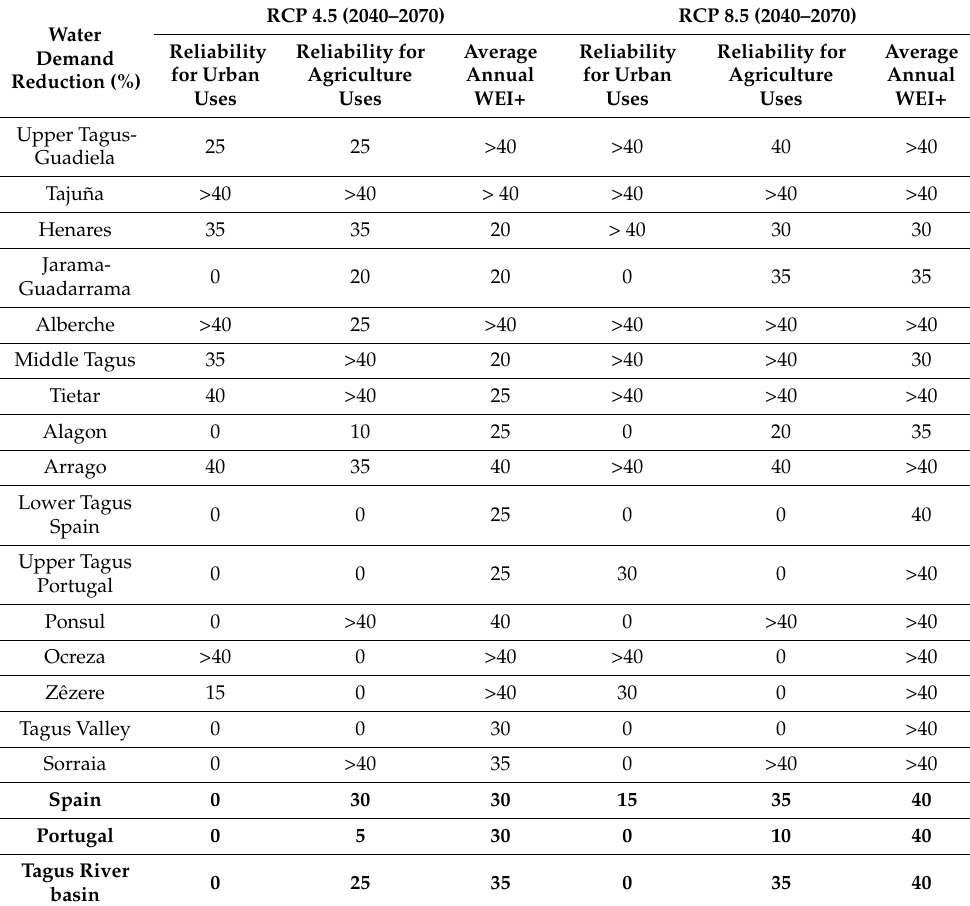
Table 4. Water demand reduction needs (%) to achieve urban and industrial reliability of 90%, agricultural reliability of 80% and the current level of